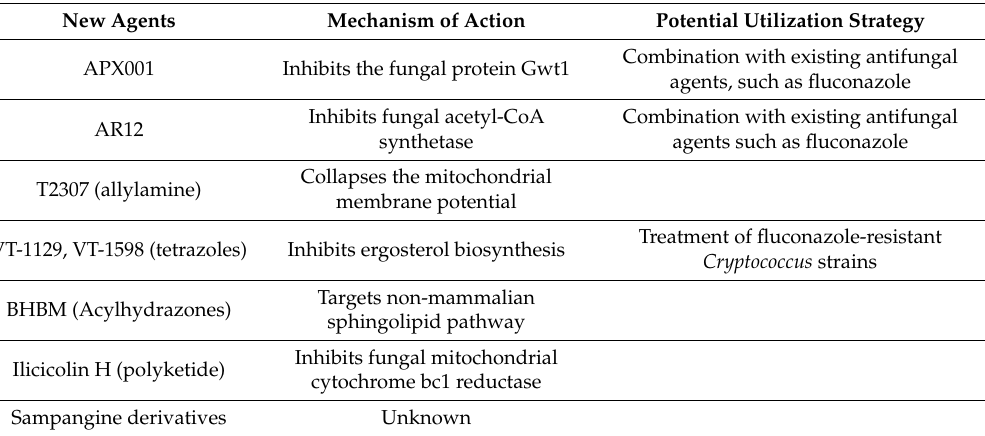
Table 1. New anticryptococcal agents in